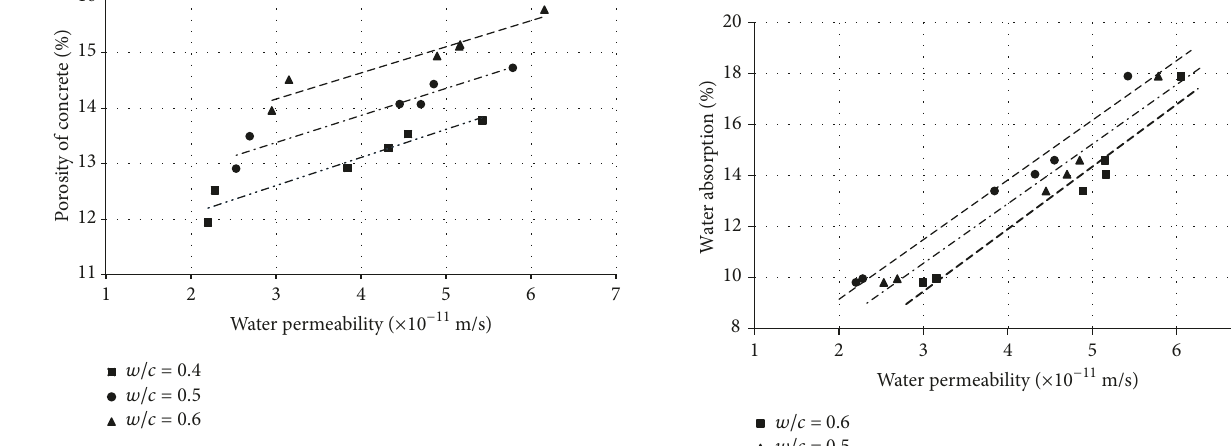
Figure 6: Water permeability coefficient with respect to porosity of hardened concrete.